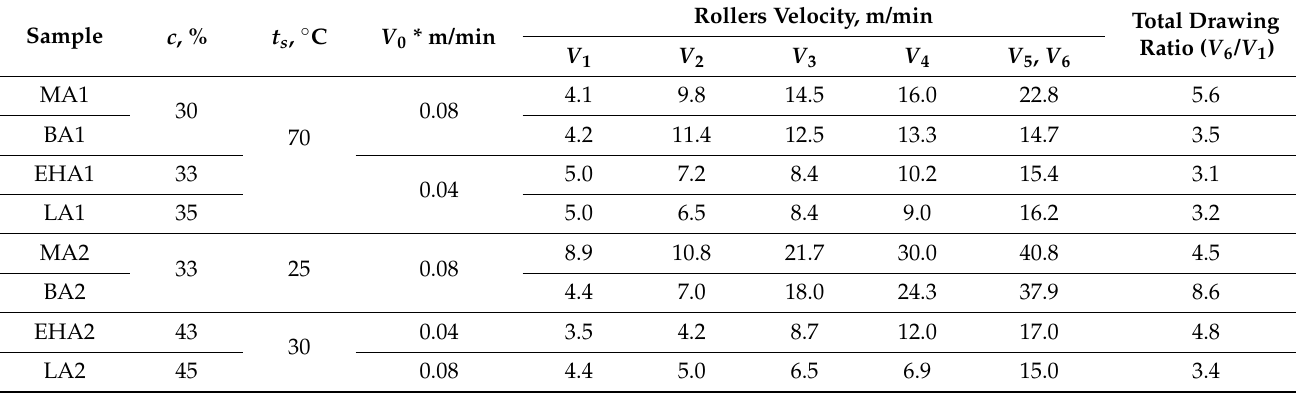
Table 3. Spinning parameters for the terpolymers under